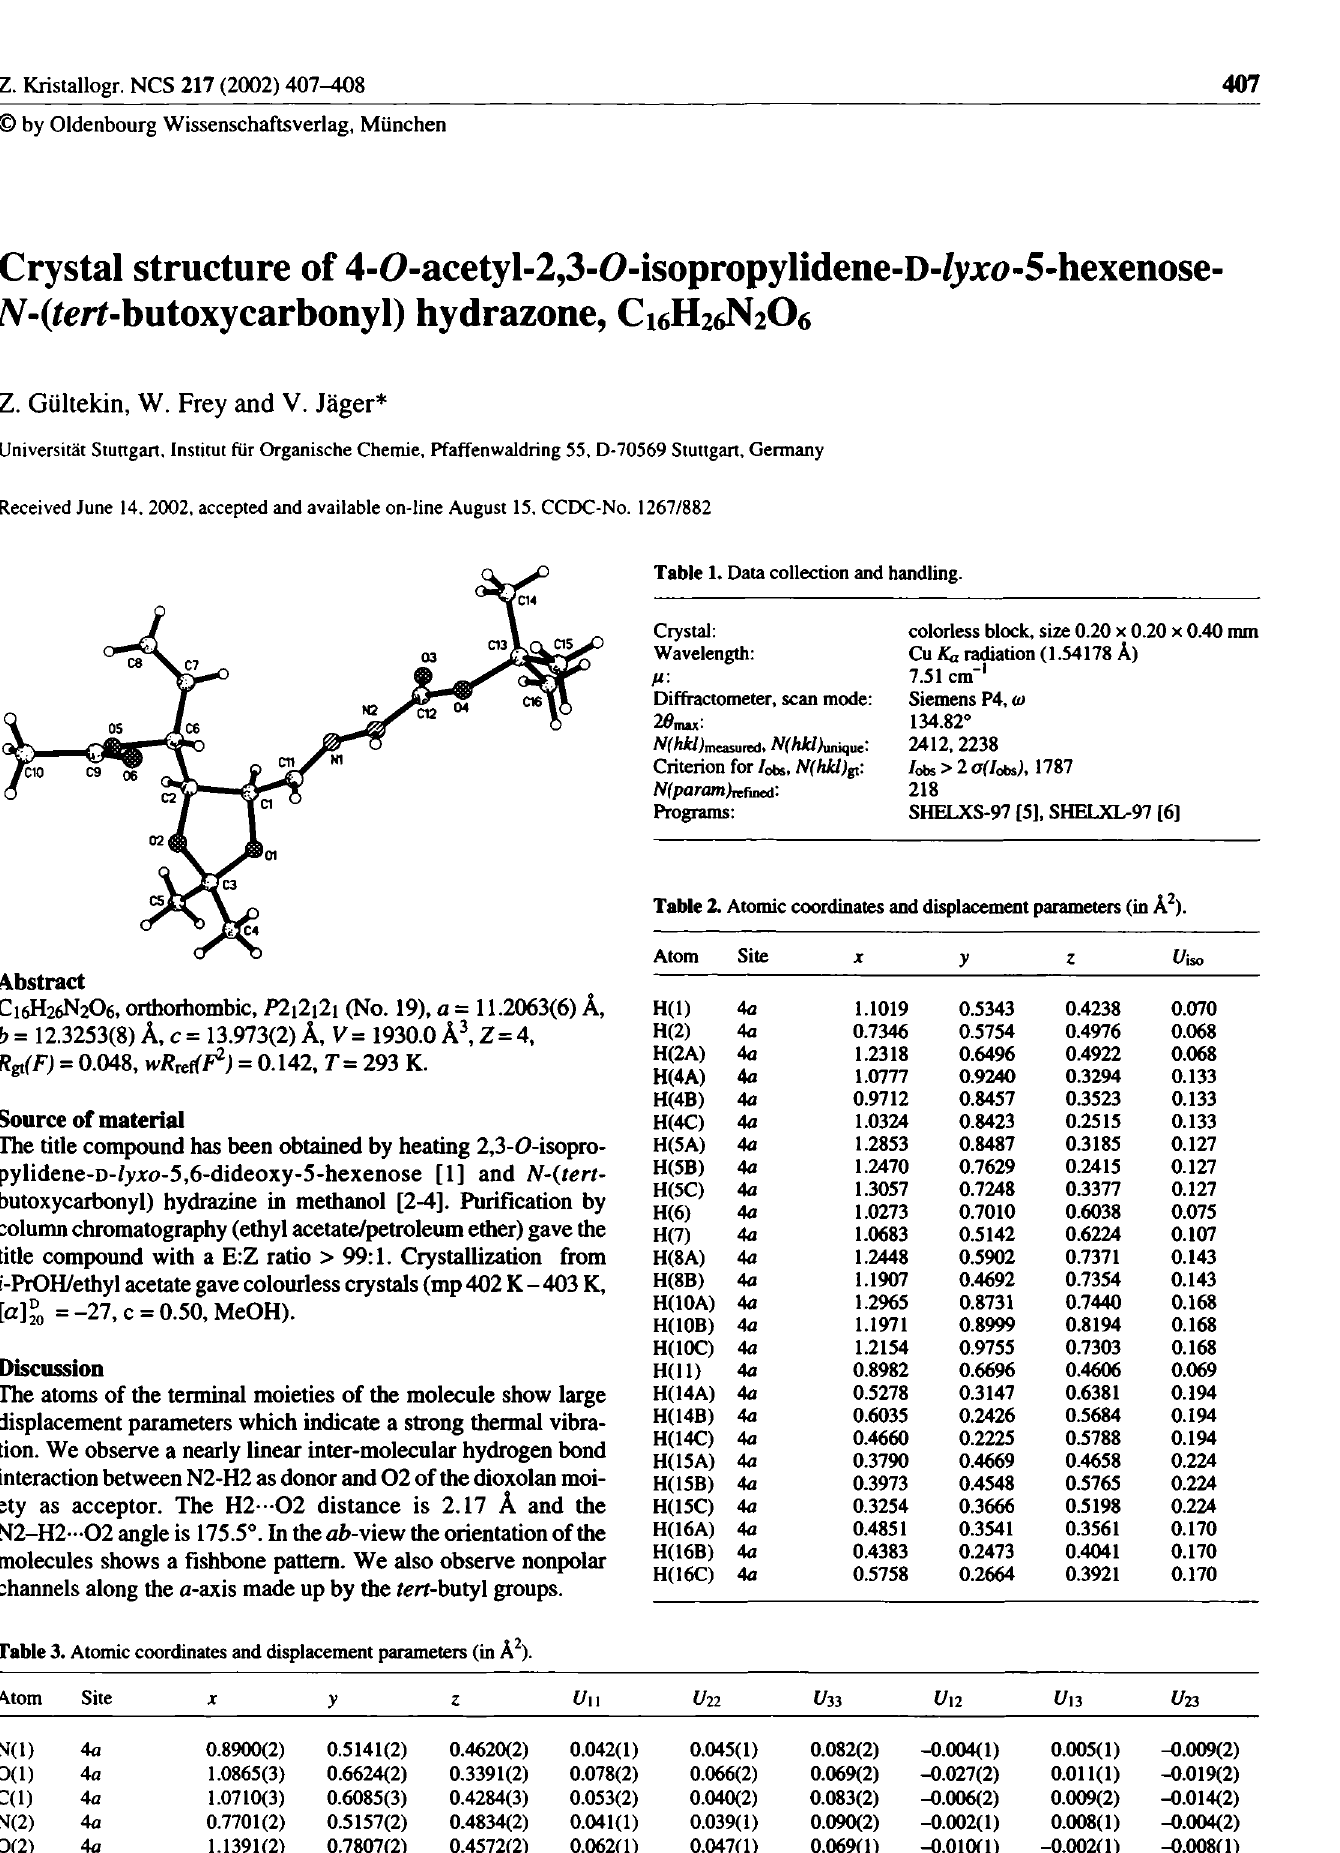
Table 3. Atomic coordinates and displacement parameters (in Â 2 ).